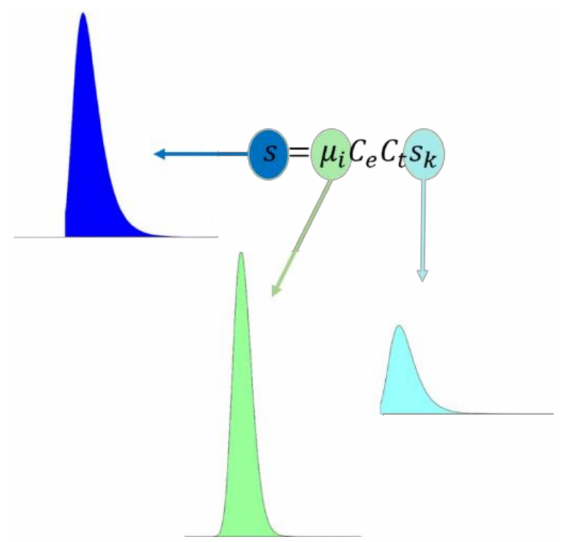
Figure 1. Stochastic distributions of snow action parameters assuming normal exposure condition (exposure coefficient C e = 1.0) and unheated building (thermal coefficient C t =